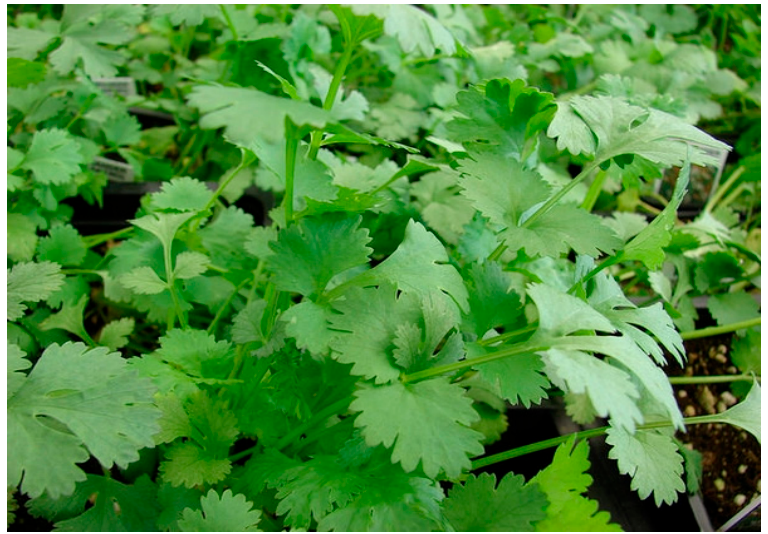
Figure 2. The leaves of Coriandrum sativum (by Forest and Kim Starr). From North Carolina Extension Gardner: Plant toolbox. (https://plants.ces.ncsu.edu/plants/coriandrum-sativum/, accessed on 20 December 2021).